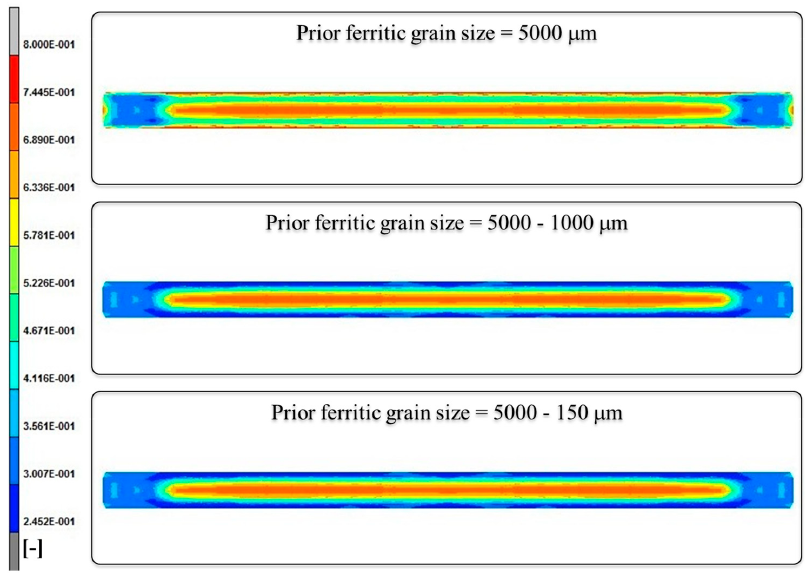
Figure 14. Effect of PFGS on damage after the fifth roughing pass.